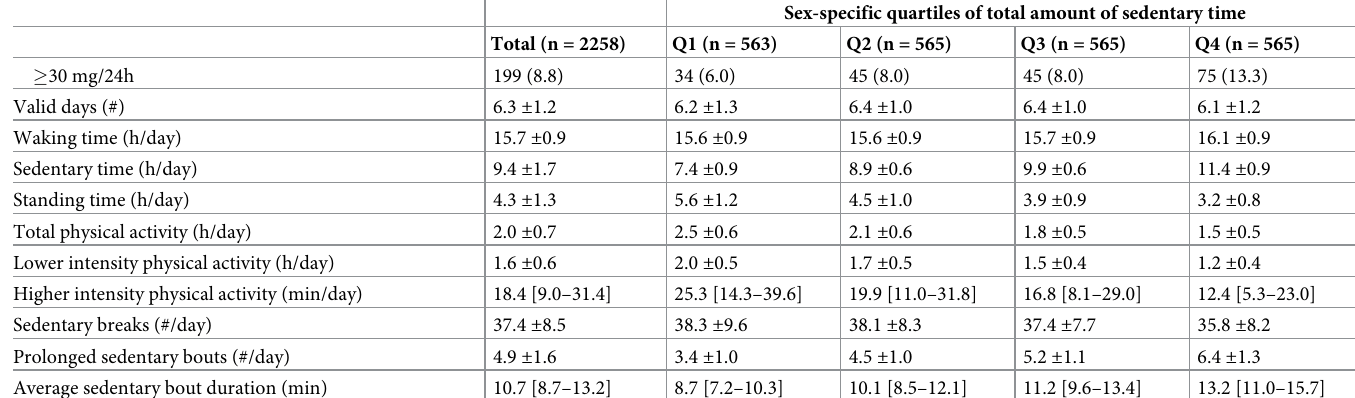
daily total physical activity; B = 2.10 (1.08; 3.12) ml/min/1.73m 2 per 1 h daily LPA; model LPA 1). After additional adjustment for potential mediators (models 4), the effect sizes were approximately 30% smaller. More daily HPA was also associated with a higher eGFR after crcys adjustment for confounders and sedentary time (B = 0.53 (0.21; 0.85) ml/min/1.73m 2 per 10 min daily HPA), but after further adjustment for potential mediators in model 4, the effect size became approximately 40% smaller and the 95% confidence interval included zero (B = 0.31 (-0.02; 0.64) ml/min/1.73m 2 per 10 min daily HPA). More daily sedentary time was associated with a lower eGFR (B = -0.71 (-1.08; -0.35) ml/min/1.73m 2 per h daily sedentary time), crcys after adjustment for confounders including HPA (model 2). After additional adjustment for potential mediators (model 4), the effect size became approximately 30% smaller. A larger number of daily sedentary breaks was associated with a higher eGFR in model 2 (B = 0.80 crcys (0.12; 1.47) ml/min/1.73m 2 per 10 daily sedentary breaks), but after additional adjustment for sedentary time in model 3, the effect size was smaller and the 95% confidence interval included zero (B = 0.59 (-0.10; 1.27) ml/min/1.73m 2 per 10 daily sedentary breaks). Having more